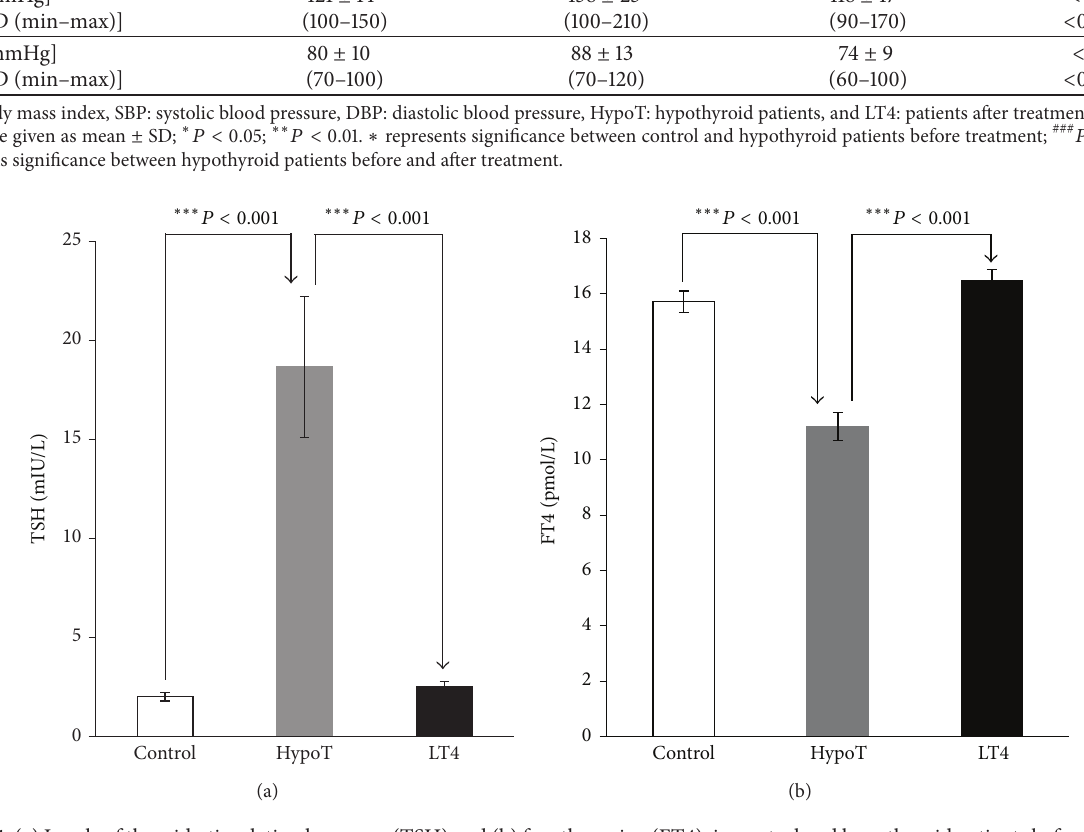
Figure 1: (a) Levels of thyroid-stimulating hormone (TSH) and (b) free thyroxine (FT4), in control and hypothyroid patients before (HypoT) and after treatment with LT4 (LT4). Values are given as mean ±